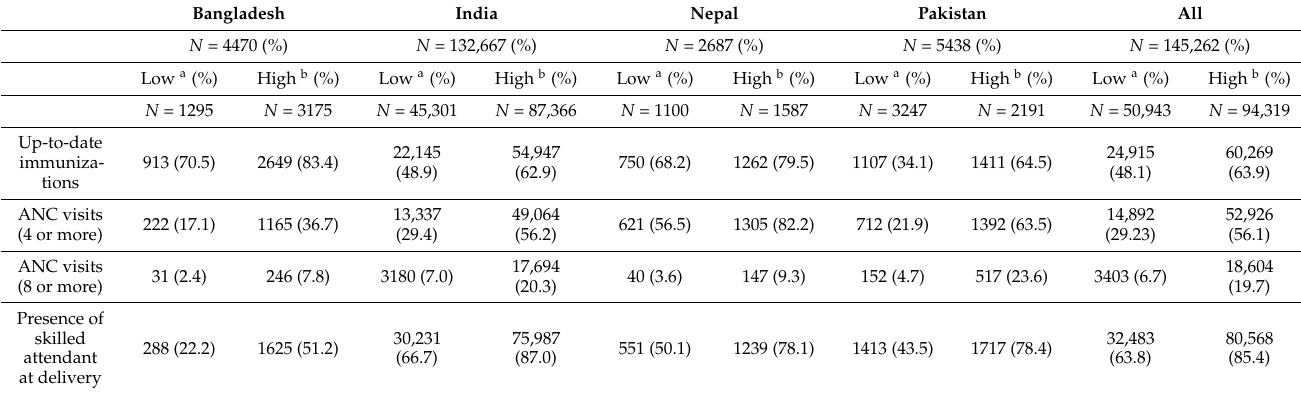
Table 3. Frequencies of maternal and child health service utilization and of access to improved water and sanitation by country and